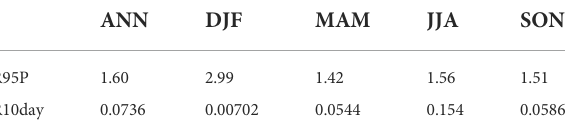
TABLE 1 Annual and seasonal growth rates of the R95P to total precipitation ratio and R10day to total precipitation day ratio, 1961 – 2018. (%/10